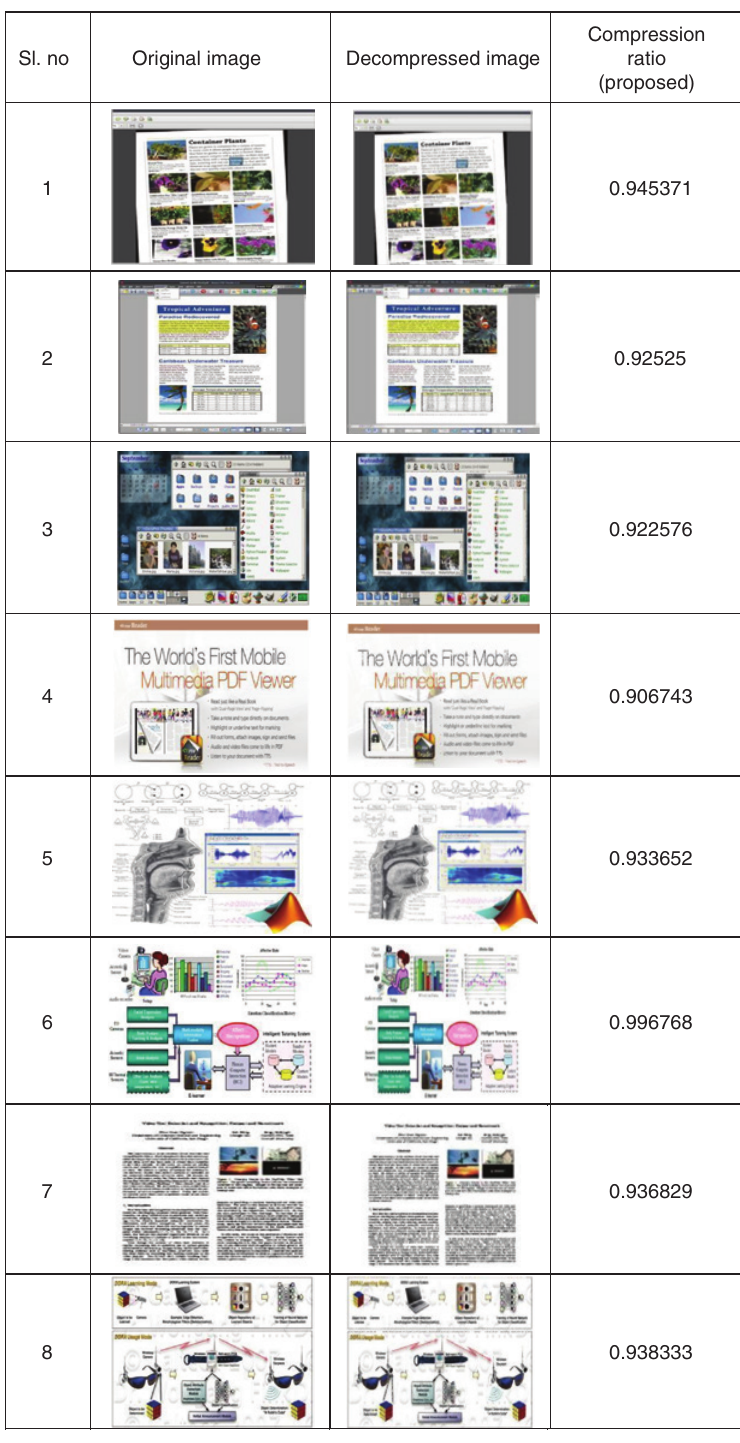
Table 1: Comparison of Reconstructed